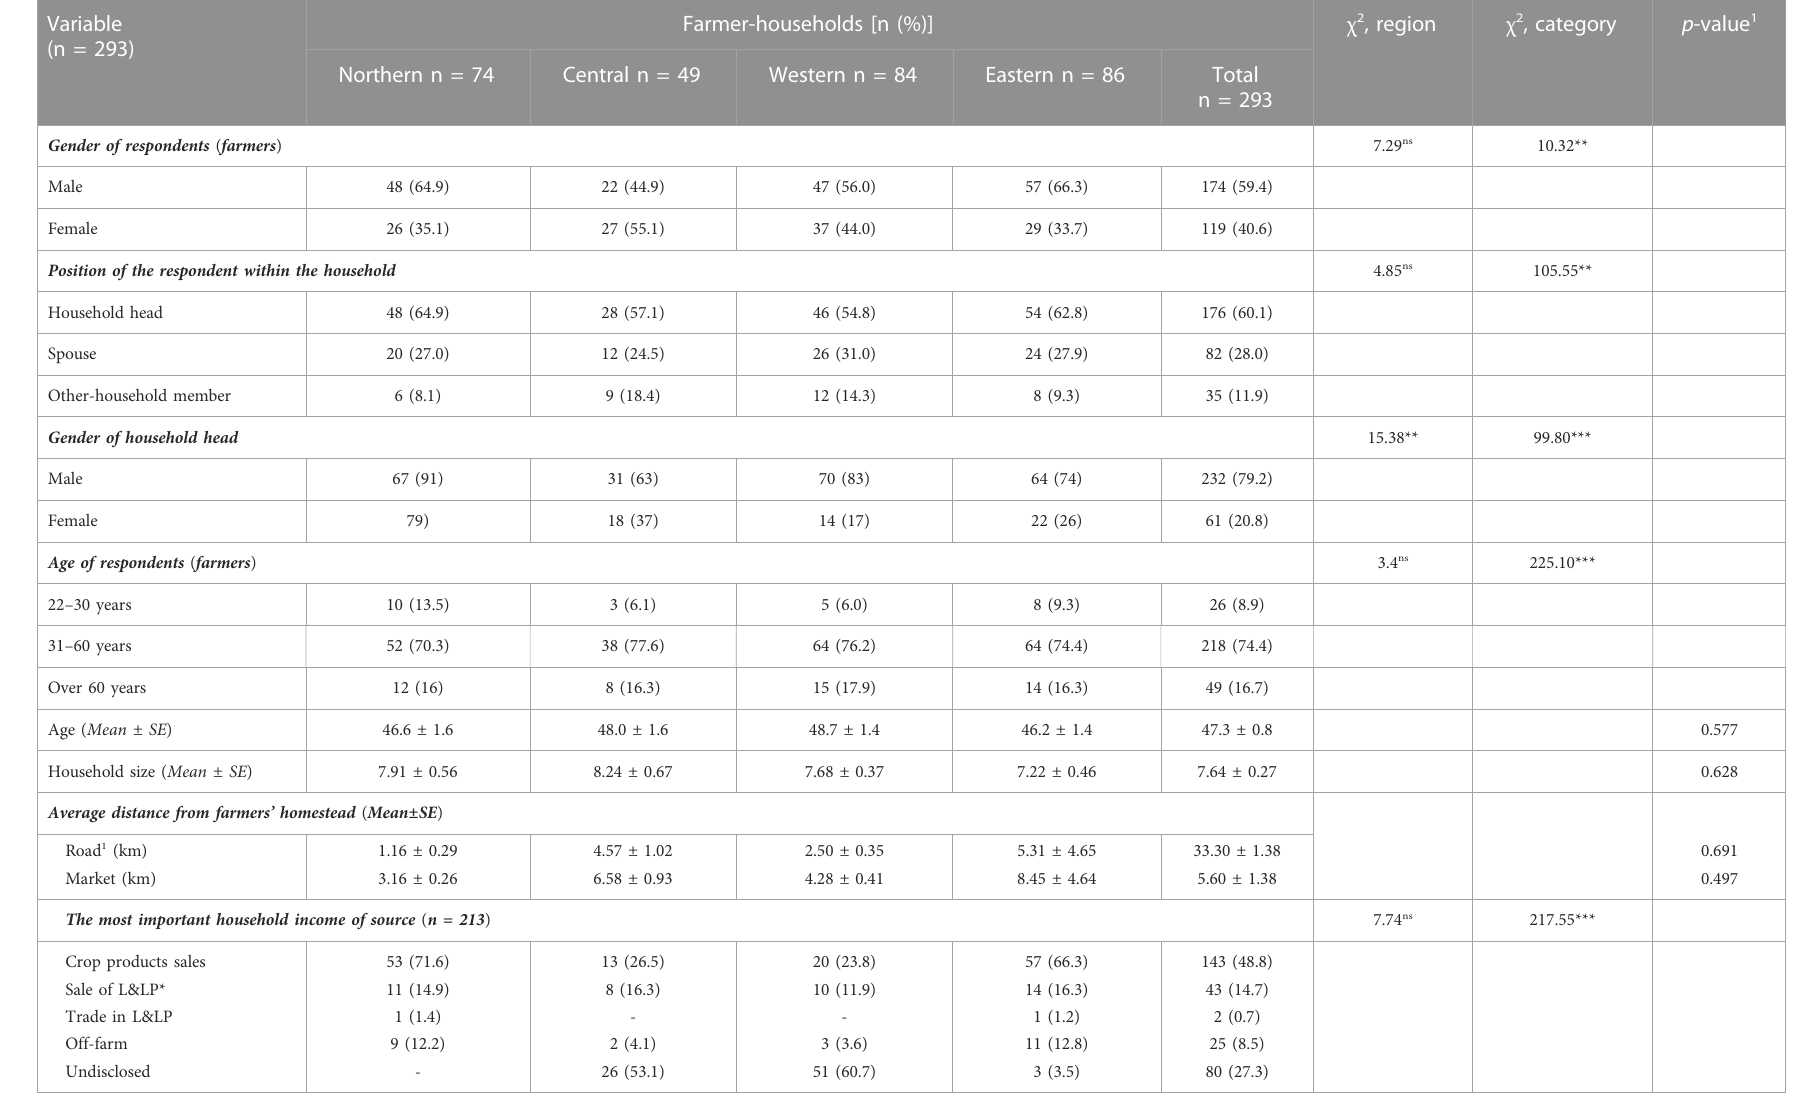
TABLE 1 Demographic analysis of indigenous chicken farmers in